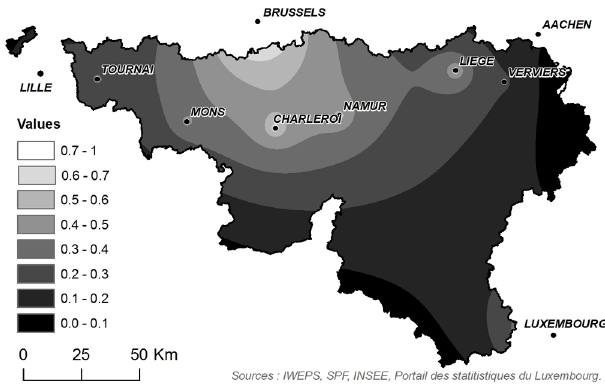
Fig. 9. Employment-related potential in the Walloon region, used to define the core settlements according to the dense urban development scenario (regional development). Values were standardized and are consequently non-dimensional.